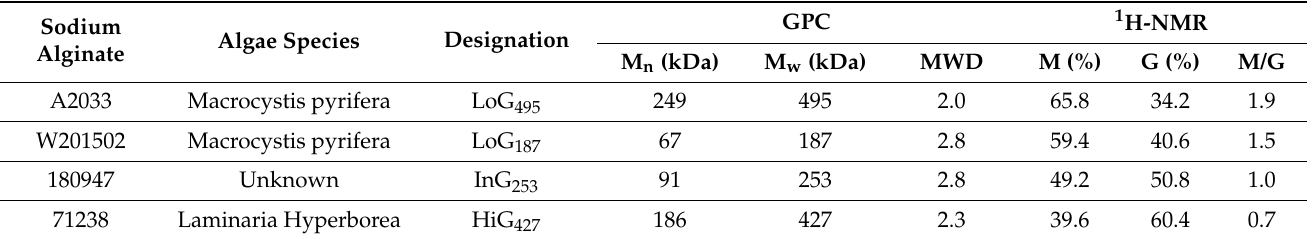
Table 1. Data obtained from GPC (PEO standards) and 1 H-NMR analysis for each